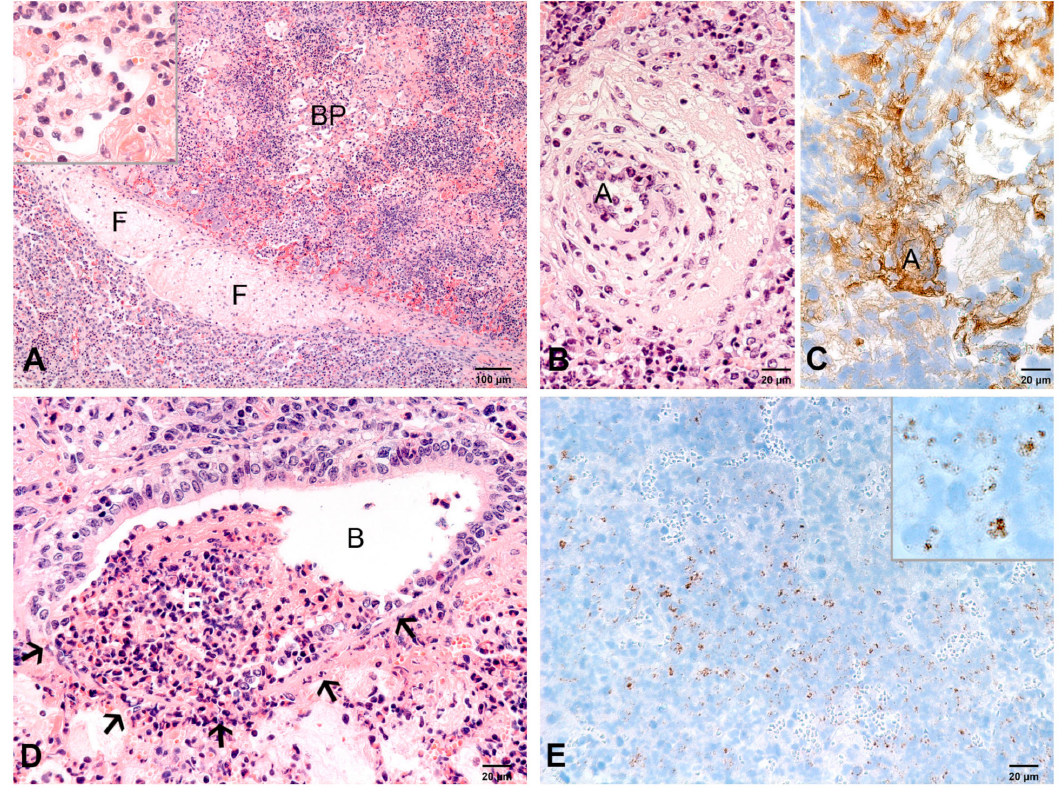
Figure 3. Pulmonary lesions at 3 dpi. ( A ) Lobular fibrinopurulent bronchopneumonia (BP) and fibrin thrombi (F) in interlobular lymphatics. Inset: higher magnification of an alveolus filled with fibrin and neutrophils. HE-stain. ( B ) Severe exudation throughout the wall and in the perivascular space of an arteriole (A). HE-stain. ( C ) Di ff use precipitates of fibrin (brown) in the wall and perivascular space of an arteriole (A) extending into the alveoli. IHC, factor VIII. ( D ) Necrosis (arrows) in the wall of a bronchiolus (B). The lumen is filled with exudate (E). HE-stain. ( E ) Numerous small chlamydial inclusions (brown) in neutrophils and macrophages. Inset: higher magnification of multiple chlamydial inclusions. IHC,